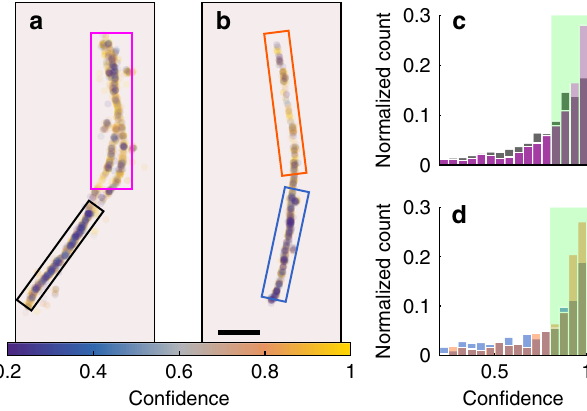
Fig. 5 Heterogeneity in Nile red interactions with amyloid fi brils. a , b WIFs of bright localizations (>400 detected photons) detected by RoSE on two fi brils. c , d WIFs of localizations within corresponding boxed regions in a (upper magenta and lower black) and b (upper orange and lower blue), respectively. Green regions indicate localizations with WIF > 0.8, corresponding to 63% ( a , magenta), 54% ( a , black), 62% ( b , orange), and 45% ( b , blue) of the localizations. Color bar: con fi dence. Scale bar: 500